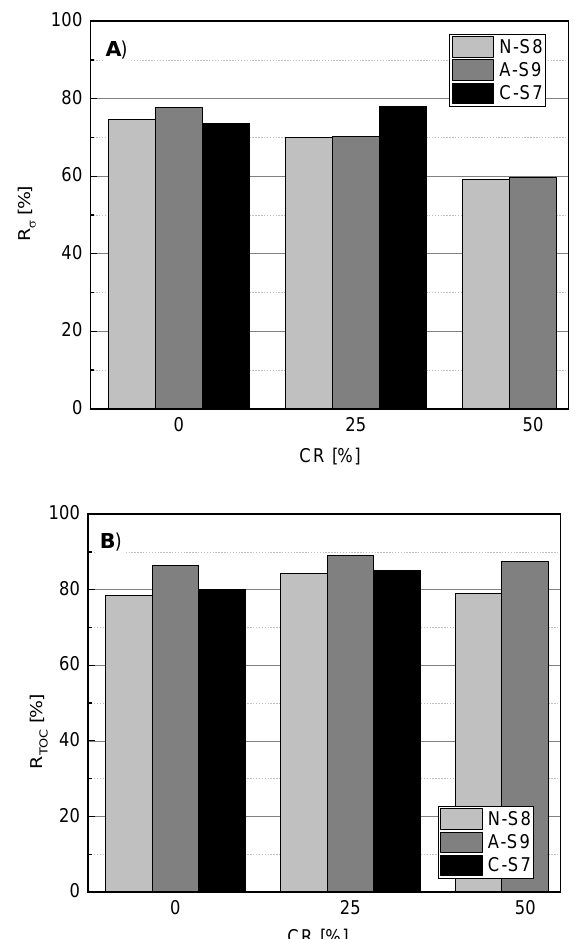
Figure 6. Reduction in ( A ) conductivity ( R σ ) and ( B ) TOC ( R TOC ) for selected surfactants vs. the concentration ratio: membrane TFC-SR3; temp 30 °C; pressure 1.5 MPa.